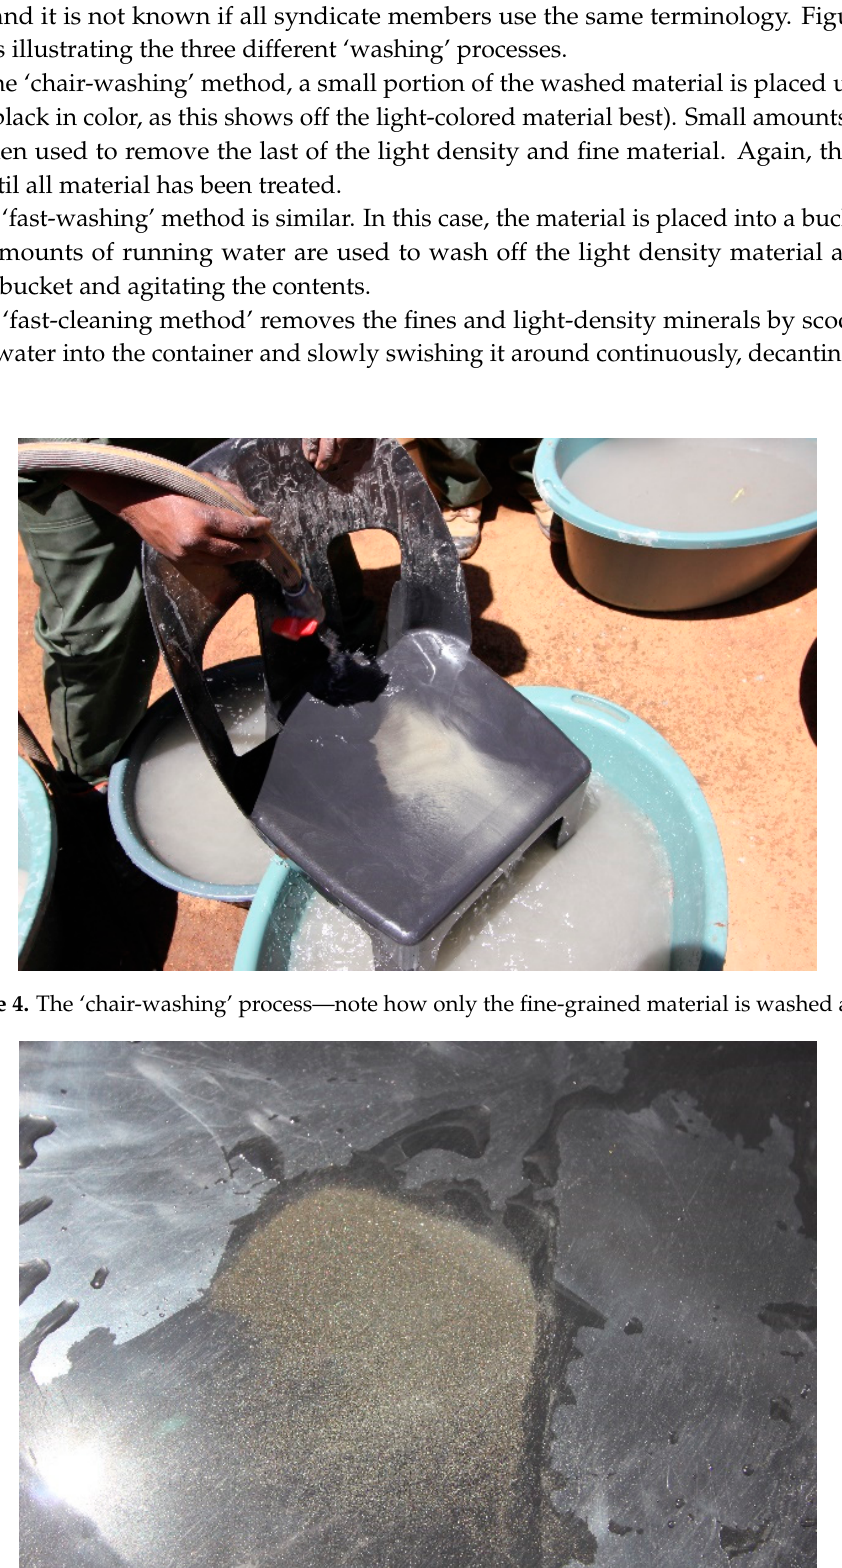
Figure 6. The ‘fast-washing’ process: small amounts of running water are used to wash off the light density material and fines. This process has also been recorded by a covert camera on one of the operations.